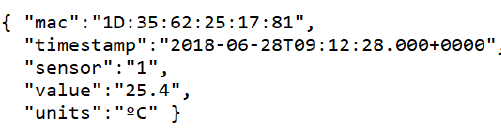
Figure 4. Smart bulb reading in JSON